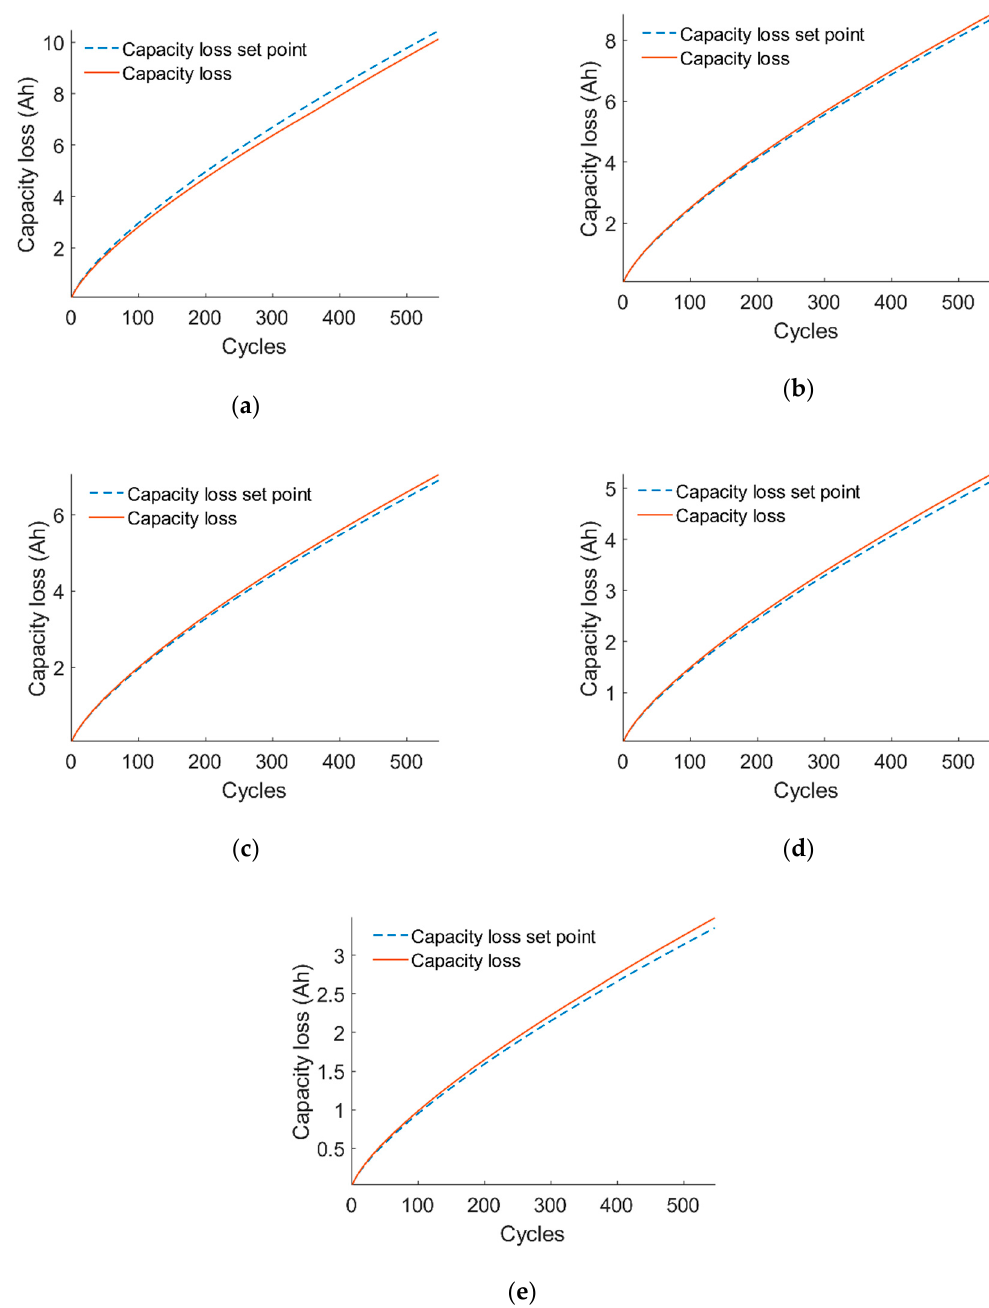
Figure 18. BESS estimated capacity loss and capacity loss trajectory: ( a ) for DOD = 80%; ( b ) for DOD = 70%; ( c ) for DOD = 60%; ( d ) for DOD = 50%; ( e ) for DOD = 40%.